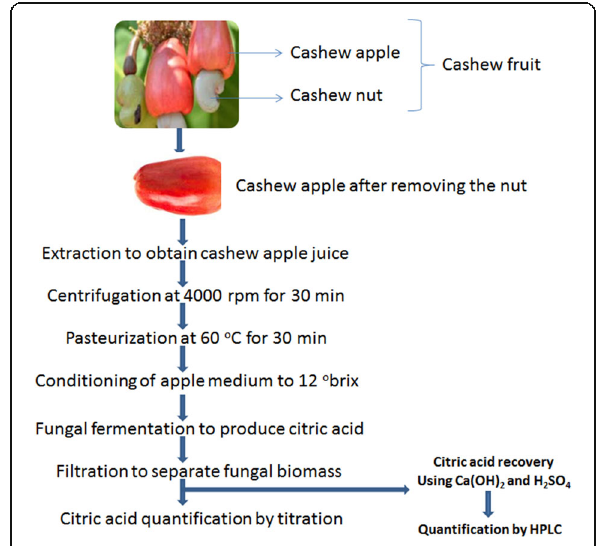
Fig. 2 Flowchart of the production of citric acid using cashew apple juice